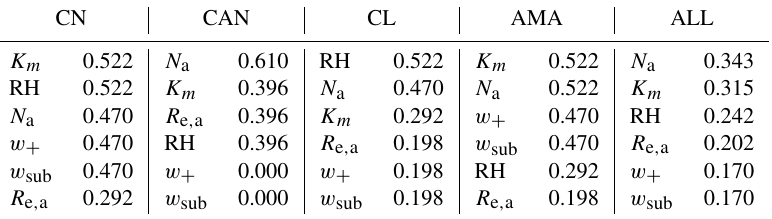
Table 4. The calculated MIC values between MRE and different input variables for each campaign and all cloud